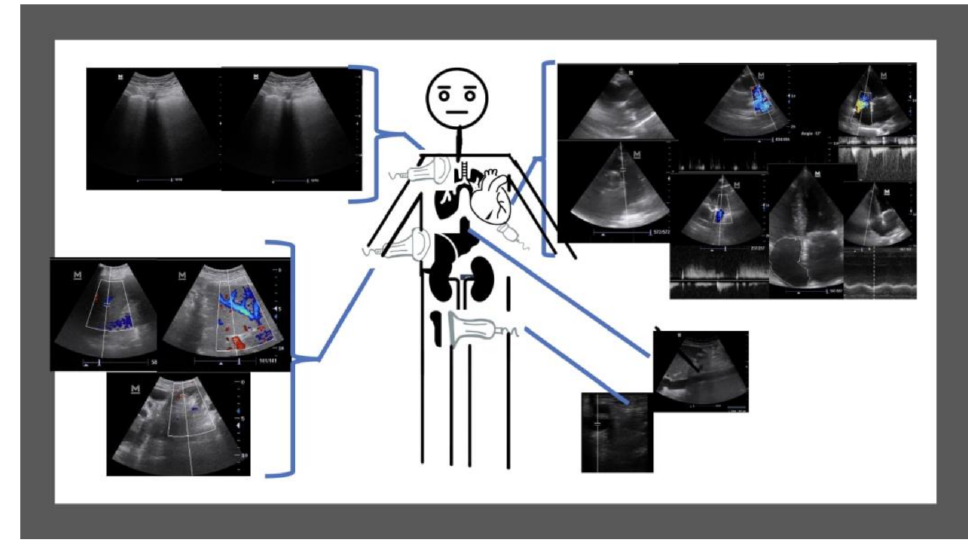
Figure 2. Representation of the ultrasound exam performed in all patients ( n = 30). Table 2. Improvement in ultrasound parameters at admission and discharge of patients included ( n =